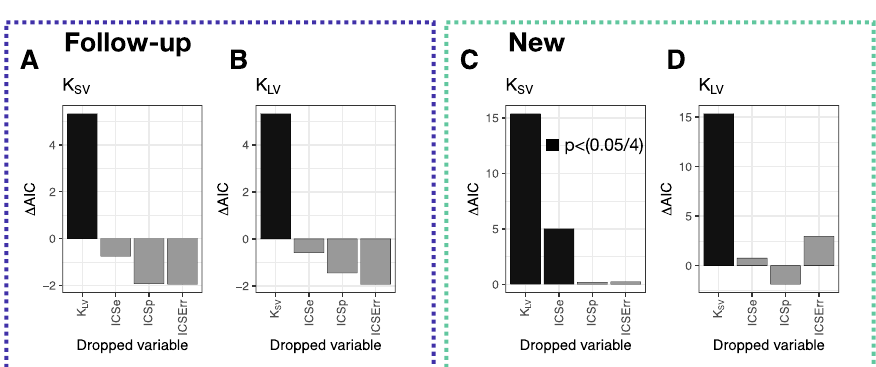
Figure 5. Drop-one regression analysis. We generated linear regression models of log ( k ) for each task (short delay and long delay) against the discount factor of the other task, as well as timing variables. In order to test which factors were important, we dropped each factor and tested whether the decrease in likelihood was significant by a χ 2 test. (Analyses were done in R using the ‘drop1’ function). We plot the change in AIC, with significant drops in black ( p < .0125 , Bonferroni Corrected p < .05 / 4 ). ( A , B )—follow-up group; ( C , D )—new group. Only for the new group and with ICSe we found some evidence that subjects’ timing was related to their discount factors. Dropping this proxy for ICS resulted in a significant decrease in the likelihood for explaining short